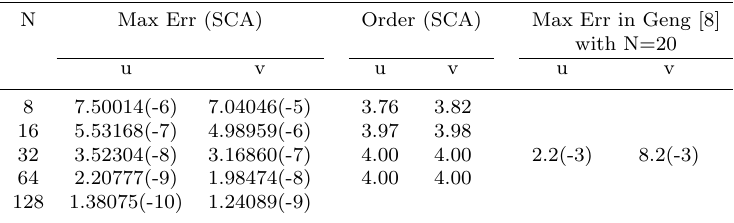
Table 2. Numerical solution of Example 2. N Max Err (SCA) Order (SCA) Max Err in Geng [8]